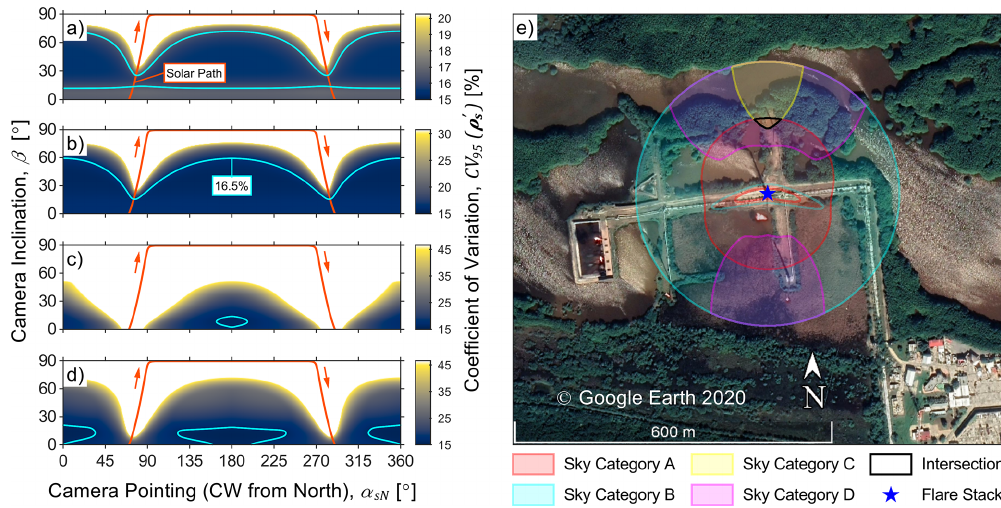
Figure 8. (a–d) Relative uncertainty (CV 95 ) in soot mass column density as a function of camera inclination ( β ) and pointing ( α sN ), maximized over the measurement day for sky categories A–D, respectively, given an observed plume transmittance ( τ obs ) of 0.90. Overlaid in the figures is the path of the sun over the day (which approximately reaches Z s = 0 ◦ at 13:05 central daylight time) in addition to a contour of CV 95 = 165%. (e) Permissible regions for sky-LOSA camera positioning relative to the studied flare stack for sky categories A– D. The black line shows the intersection of these regions which is ∼ 600m 2 at which the sky-LOSA camera can be positioned to minimize measurement uncertainty, regardless of sky